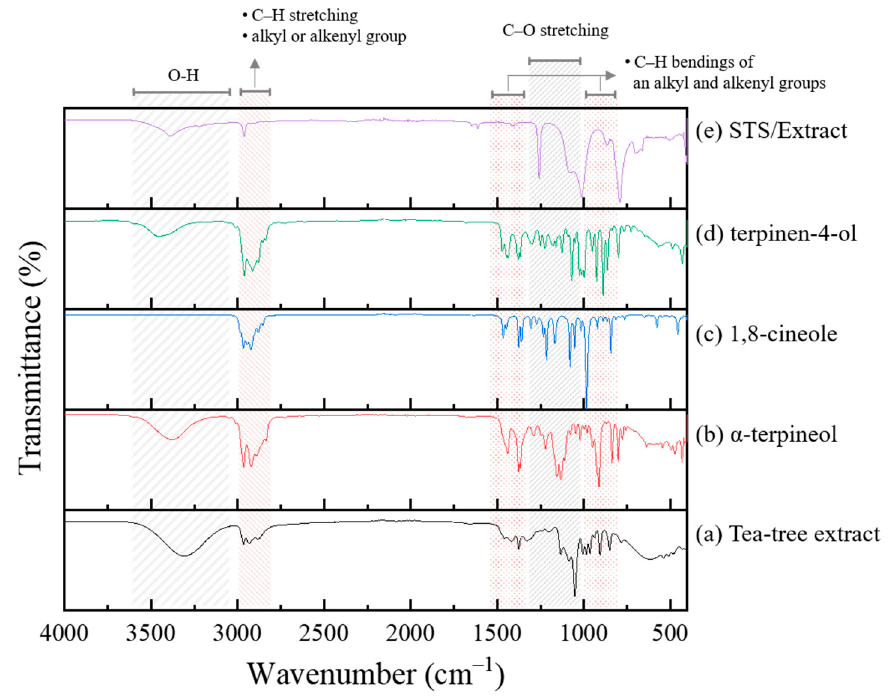
Figure 7. FTIR spectra of ( a ) tea tree extract, ( b ) α -terpineol, ( c ) 1,8-cineole, ( d ) terpinen-4-ol, and ( e ) the inhibited STS specimen in 1 M HCl solution containing 0.75 g/L of tea tree extract. The FTIR spectrum was analyzed from the surface of the STS specimen after the immersion test in 1 M HCl solution containing tea tree extract (Figure 7e). The relative intensity and position of carbon peaks for the inhibited specimens were changed compared to those for the original tea tree extract and constituents. A notable change in Figure 7e was the weakening of relative intensity for the O–H vibration peak compared to the original tea tree extract and other constituents (Figure 5a,b,d). The constituents of tea tree extract such as α -terpineol and terpinen-4-ol are believed to be adsorbed through chemical interactions between their hydroxyl (O–H) group and the steel surface